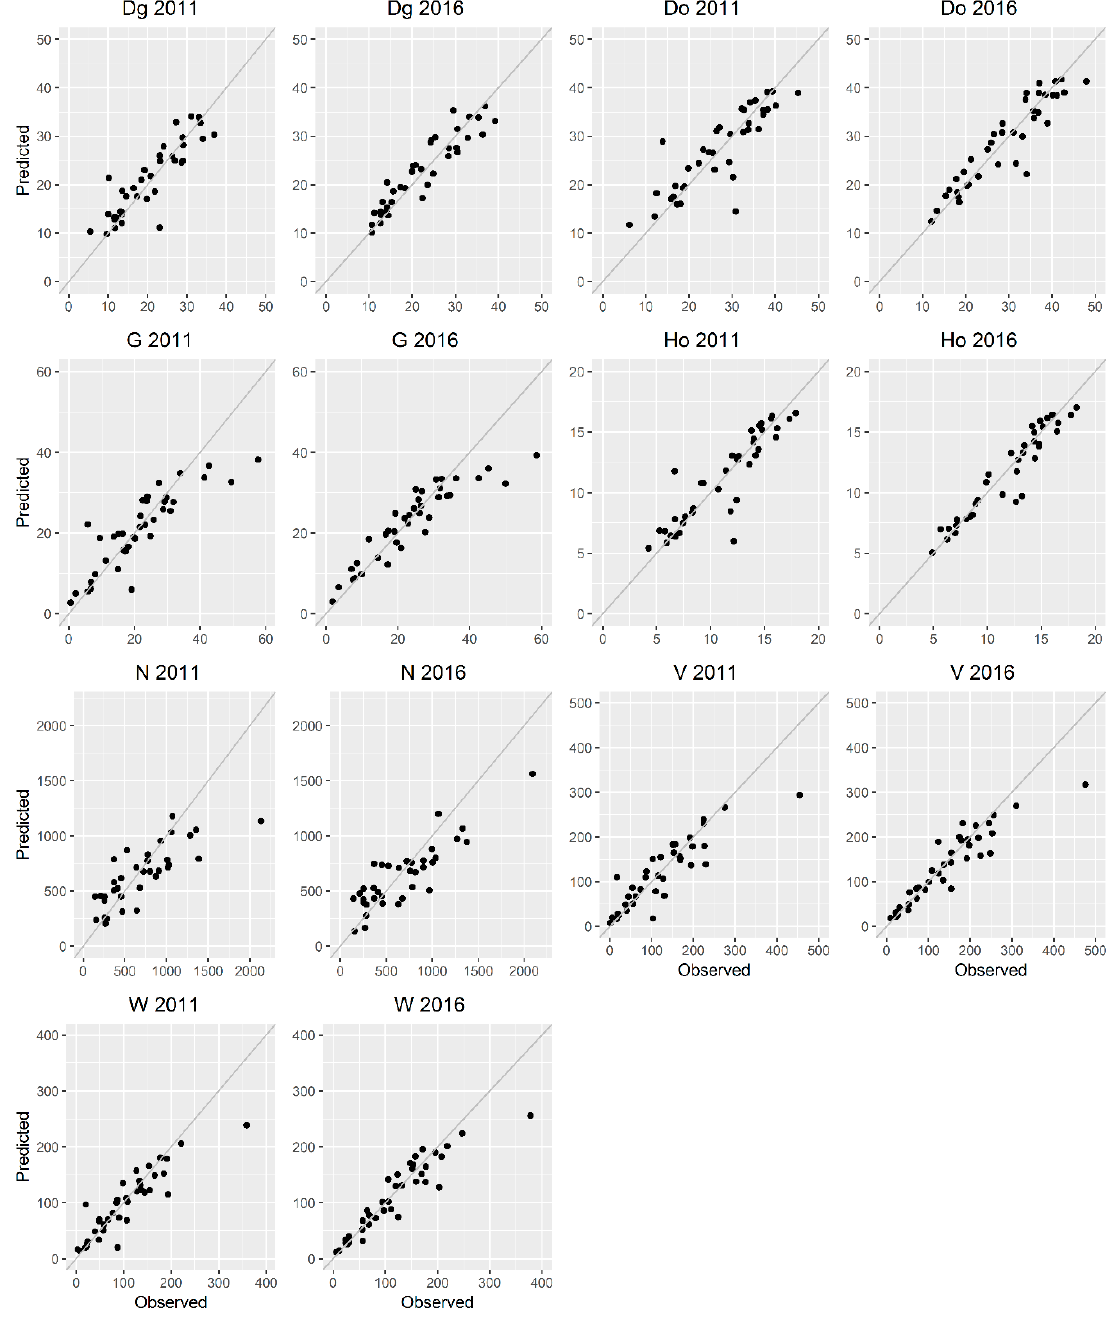
Figure A2. Scatterplot of predicted vs. observed values of the forest stand variables using the best-selected SVM with radial kernel 2016 models and 2011 extrapolated models. Dg and Do are expressed in cm; G is expressed in m 2 ha -1 ; H is expressed in m; N is expressed in stems ha -1 ; V is expressed in m³ ha -1 ; W is expressed in tons ha -1 .